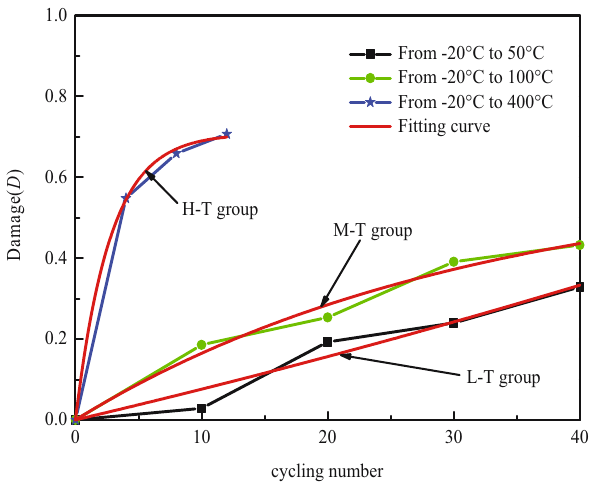
Figure 6: Relationship between damage and cycling number in H – C